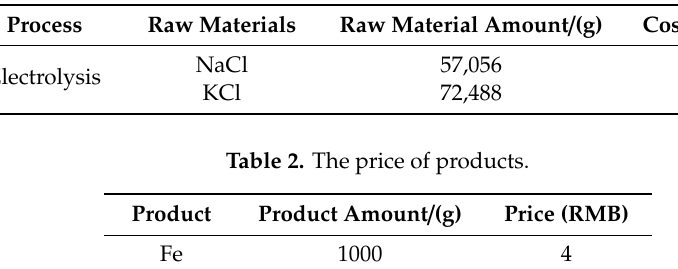
Table 1. The cost of materials required to produce 1 kg Fe.